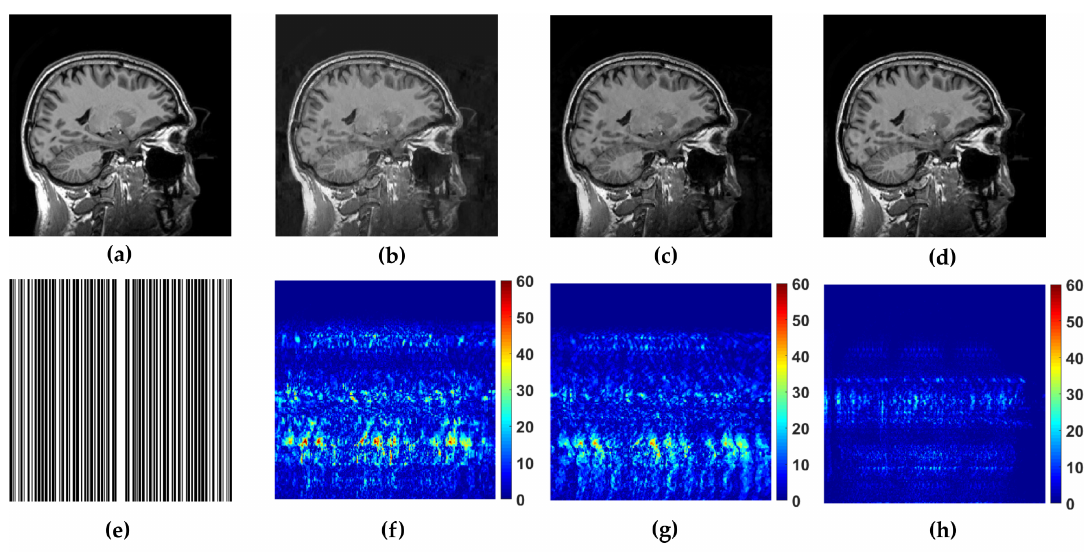
Figure 5. Reference image ( a ) sagittal and its reconstruction with the folowing methods ( b ) WaTMRI (PSNR = 28.70 dB, SSIM = 0.81), ( c ) LaSAL2 (PSNR = 29.77 dB, SSIM = 0.84) and ( d ) FCSLa (PSNR = 36.49 dB, SSIM = 0.97) using 45% of measurements sampled with trajectory shown in ( e ). The corresponding reconstruction error of the used methods are shown in ( f – h